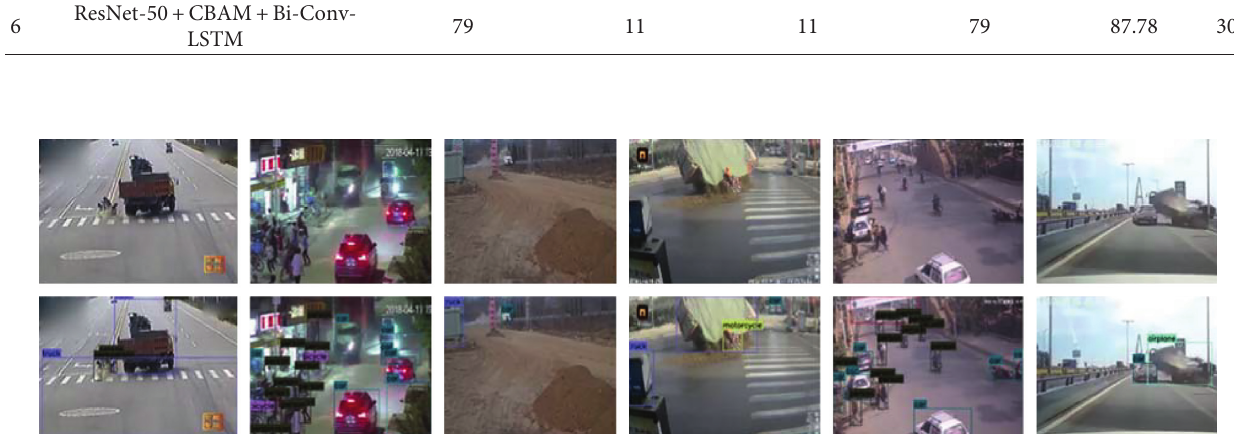
Figure 10: False-negative examples of Model 1.